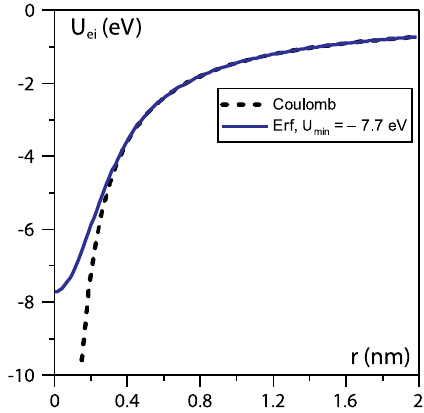
FIG. 2. Electron-ion interaction potential: dashed line—pure Coulomb; solid line—the one used in this